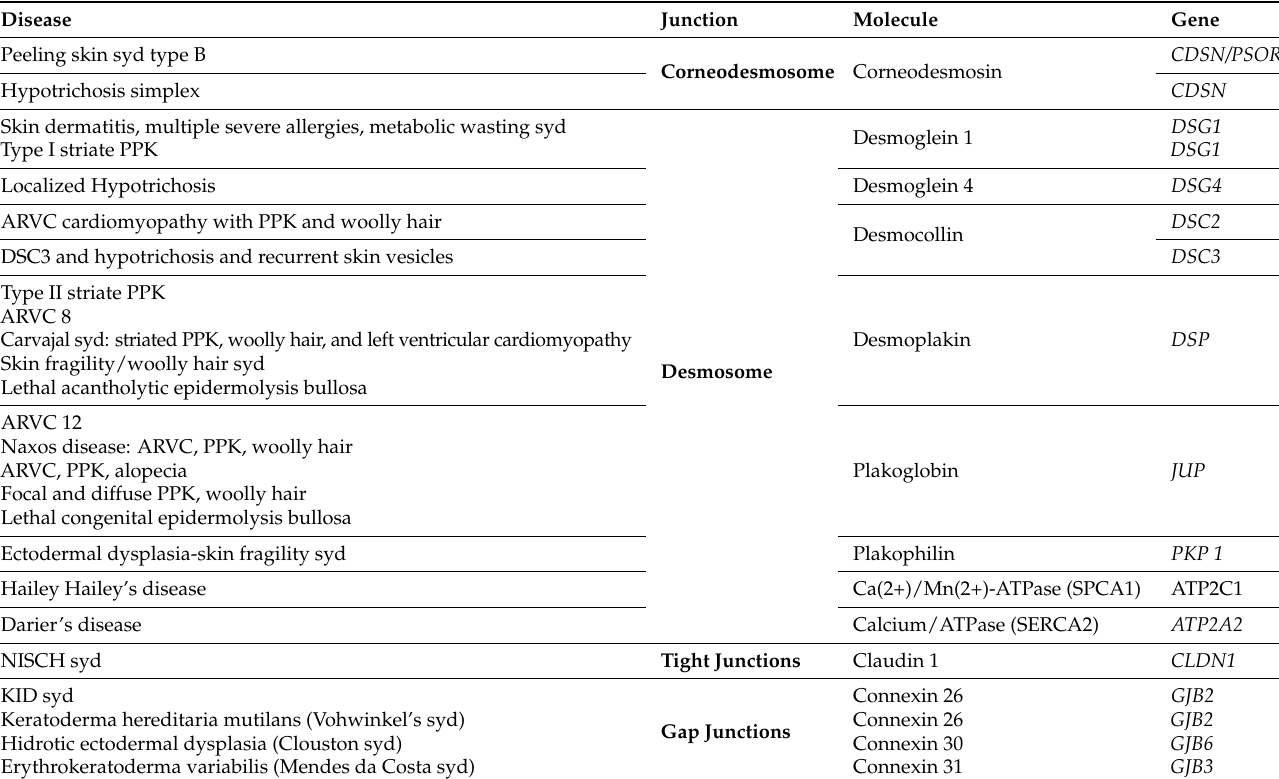
Table 2. Epidermal Junctions-related Genetic Disorders. Adapted from Haftek [40], Guerra et al. [43] and Petrof et al. [44]. PPK: Palmo-Plantar Keratoderma; ARVC: Arrhythmogenic right ventricular cardiomyopathy; syd: syndrome.